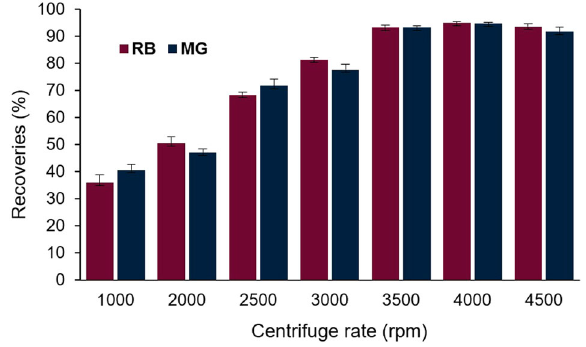
Fig. 3 Effect of centrifuge rate on extraction ef fi ciency. Extraction conditions: water sample volume: 10 mL, spiked concentration: 500 ng mL − 1 , extraction solvent: chloroform (120 µL), dispersive solvent: ethanol (760 µL), sonication time: 4 min, pH: 5. Error bars represent standard